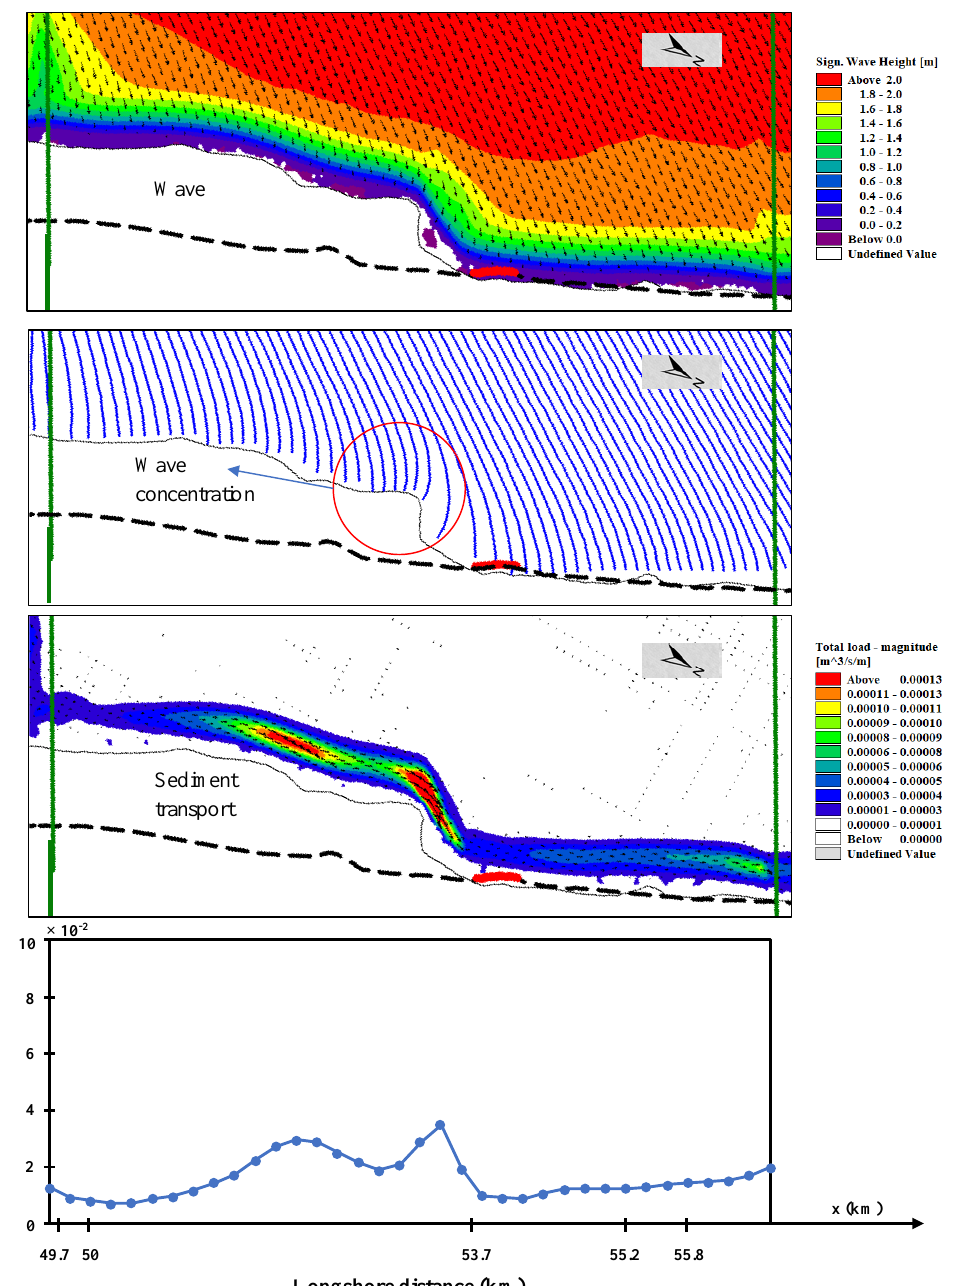
Figure 23. Snapshots of the wave field, wave ray, sediment transport field, and the distribution of alongshore sediment transport flux during a high-energy event on 18 July 2009 (H = 2.1 m, T = 8.6 s, and θ = 212.6°) around the low-amplitude spit. The arrow indicates the resultant direction of wave and sediment transport. The red circle indicates wave concentration around the spit. The dotted line indicates Marine Drive Road. The red line represents the revetment. Since the littoral drift movement is parallel to the shoreline, there are two possible directions of motion, right or left, relative to the observer on the shore looking out to sea. The net longshore transport/littoral drift is the difference between the amount of littoral drift transported to the right and that to the left past a point on the shoreline. A numerical model was able to calculate the